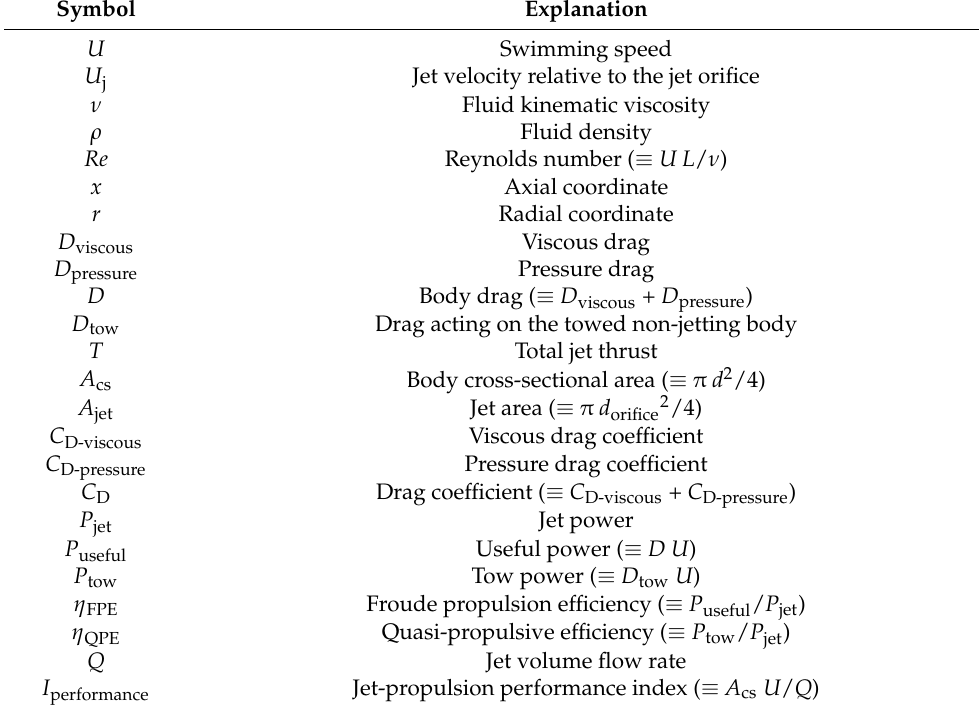
against Re × e , Figure S2: Line plots of η FPE , η QPE , P useful , P tow , and P jet against Re × e , and Figure S3: Line plots of Q and I performance against Re × e , for all simulated